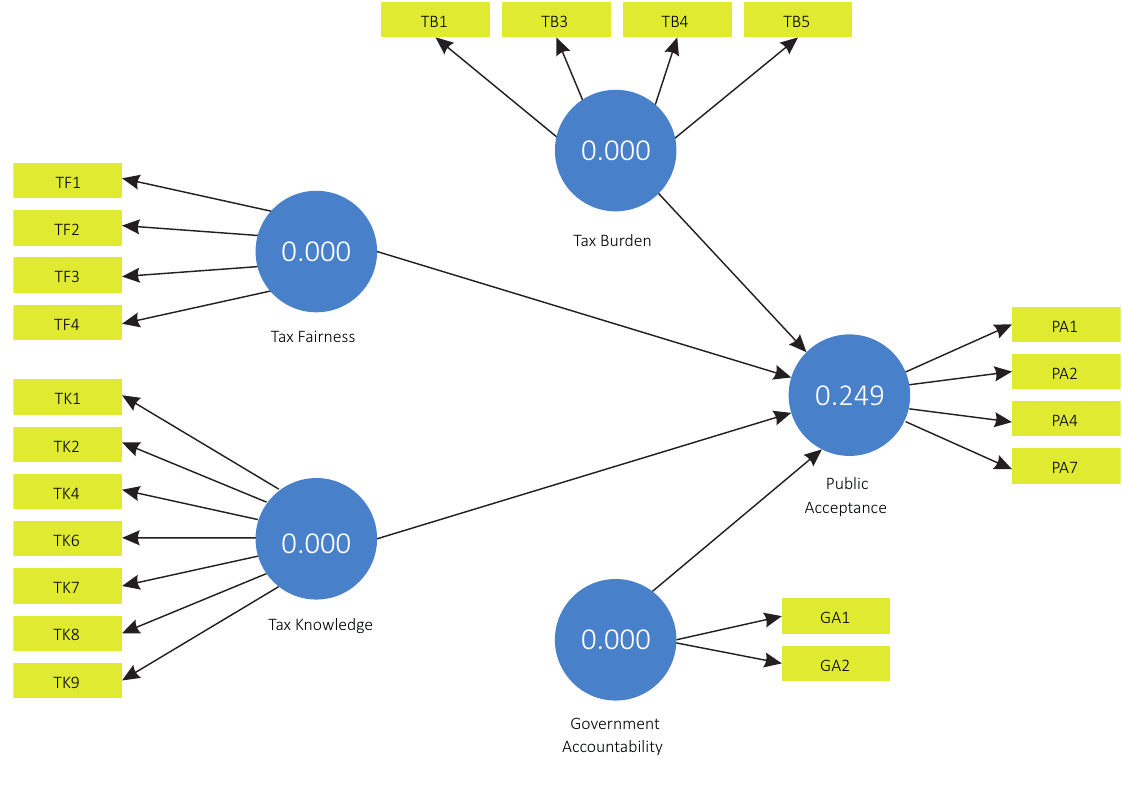
Figure 4a. Assessing Q-squared (Q 2 ) effect size